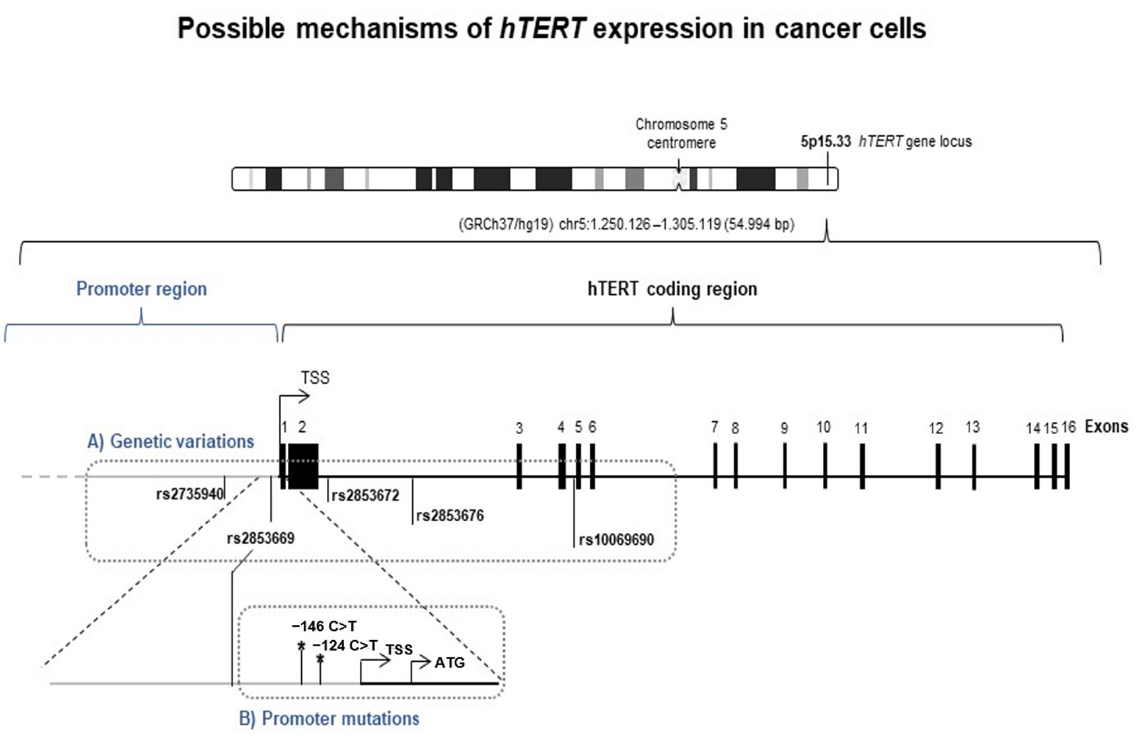
Figure 1. Possible mechanisms of hTERT expression in cancer cells. Telomerase activity in cancer cells is related to the acquired expression of hTERT gene located at the short arm of chromosome 5. hTERT transcription activation may be due to germline genetic variations and promoter hotspot mutations. ( A ) Localization of hTERT germline genetic polymorphisms associated with cancer risk in promoter (rs2735940 and rs2853669) and in gene coding region (rs2853672, rs2853676, rs10069690). The 16 exons of hTERT gene are represented by black vertical bars. ( B ) hTERT promoter hotspot mutations (*) − 124 bp and − 146 bp upstream the ATG. Genomic coordinates are based on build 37 (GRCh 37, hg19/Human). hTERT: human telomerase reverse transcriptase; bp: base